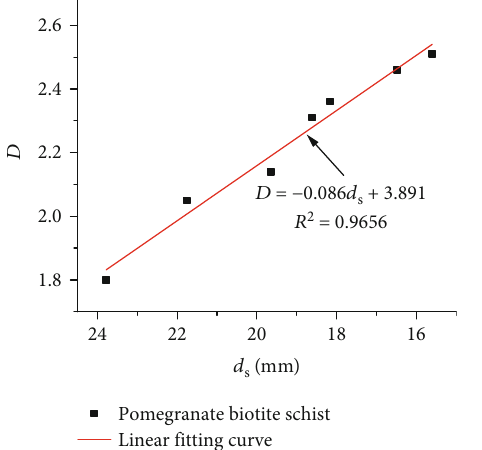
Figure 8: Relation between fractal dimension and average block size for pomegranate biotite schist.